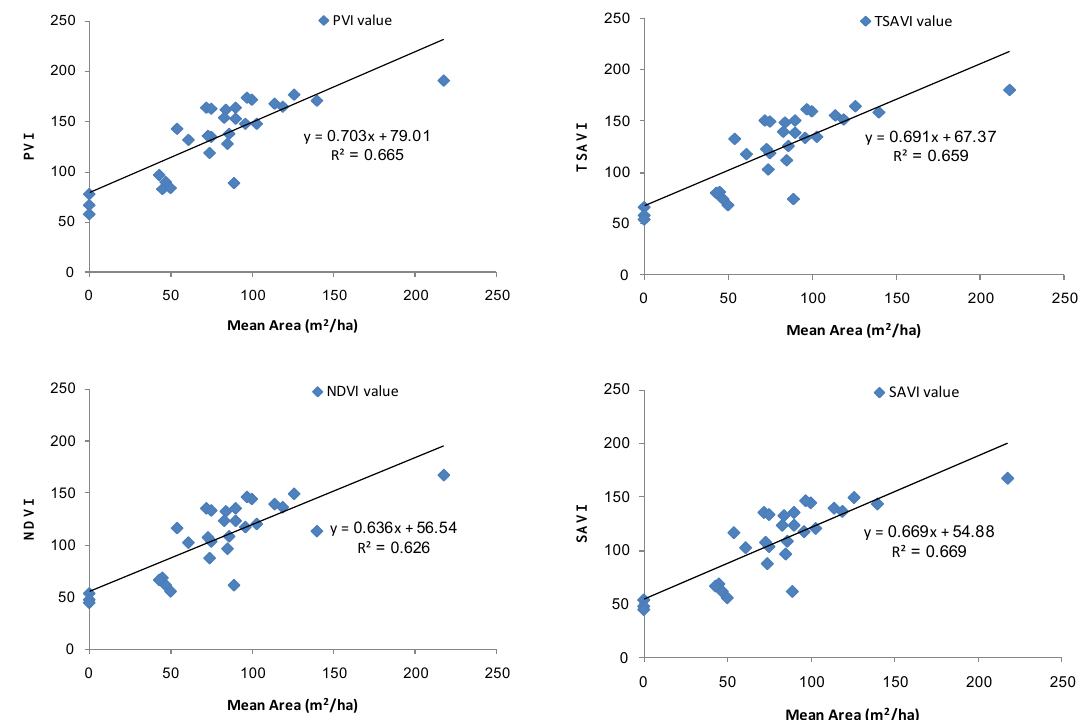
Figure 3 : The scatter plot, regressions models and correlation between the crown area (m 2 /ha) with the remotely sensed data (vegetation